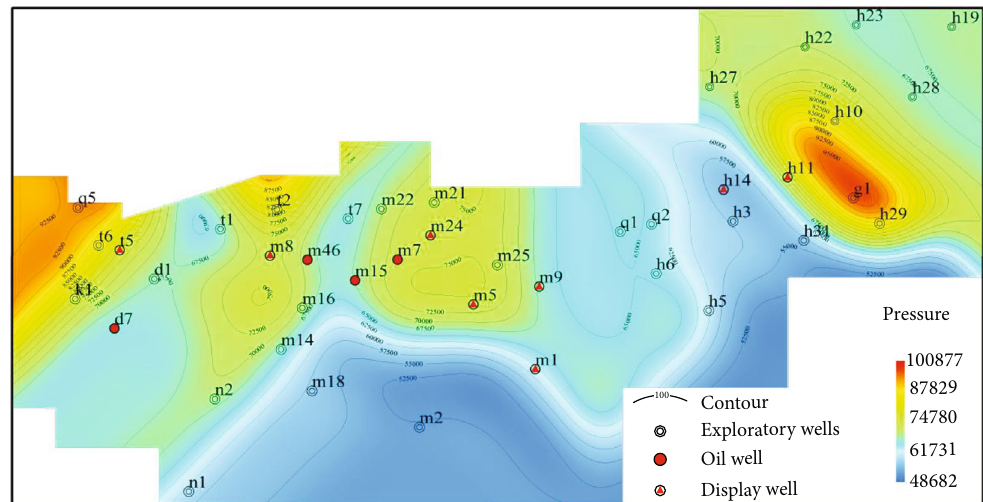
Figure 11: Distribution of Cretaceous paleopressures during deposition of the Kangcun Formation in the western Tabei area.